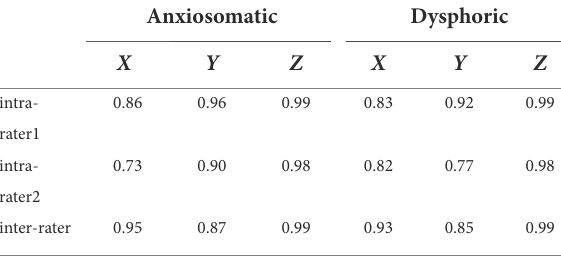
TABLE 1 The correlation of Brainsight coordinates between-and within-raters.